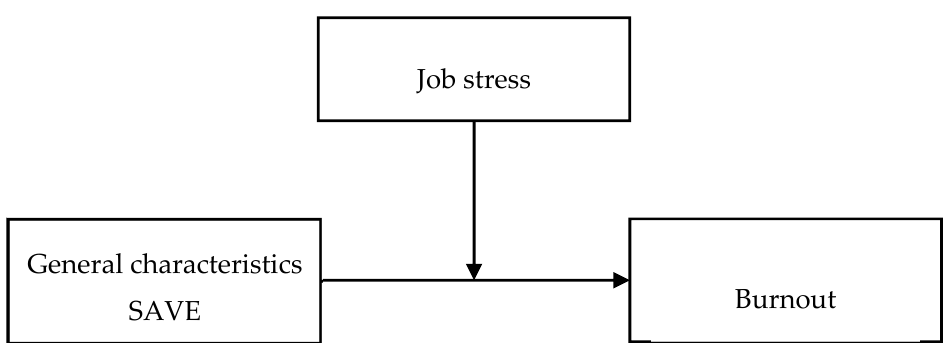
Figure 1. Hypothesis model of research. SAVE = Stress and Anxiety to Viral Epidemics.